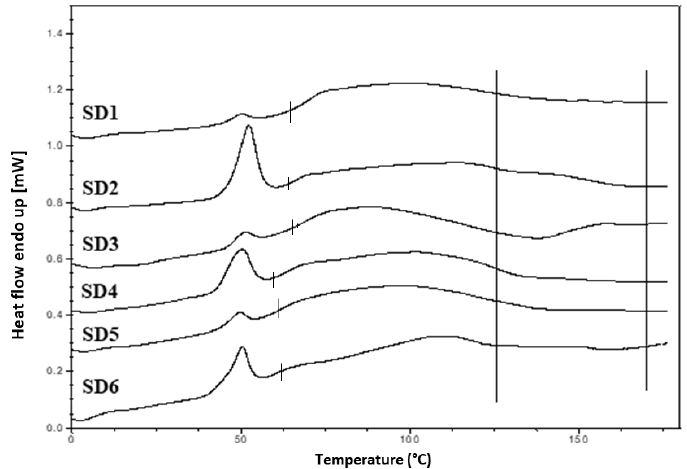
Figure 8. Hyper DSC thermograms of air-cooled SD formulations. Hyper DSC indicates that INM was converted to its amorphous form. The area of interest for T g is marked by the straight lines.